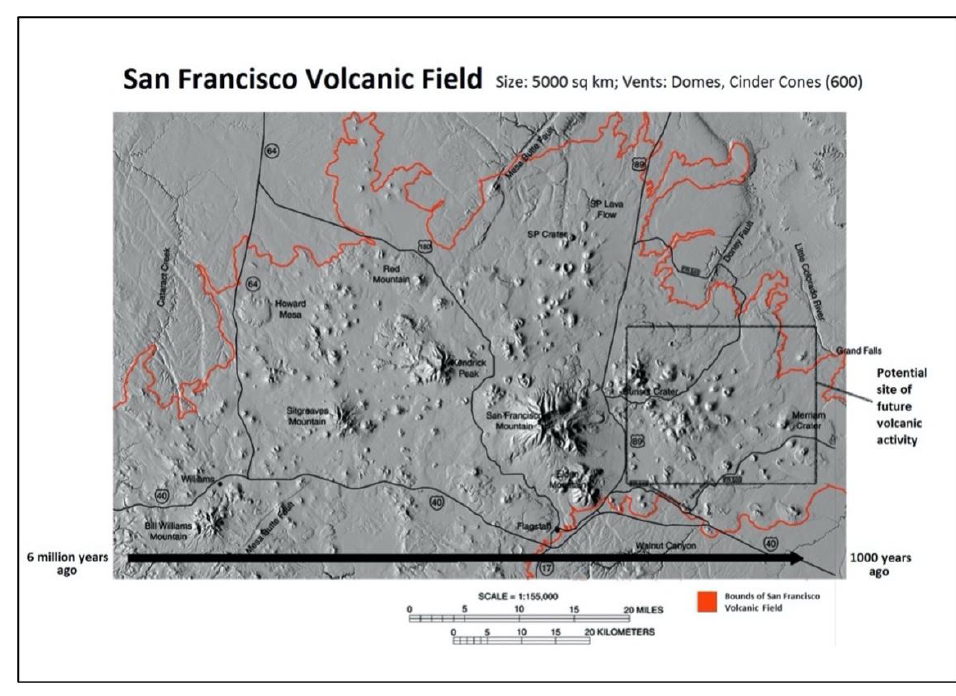
Figure 2. San Francisco volcanic field [28].